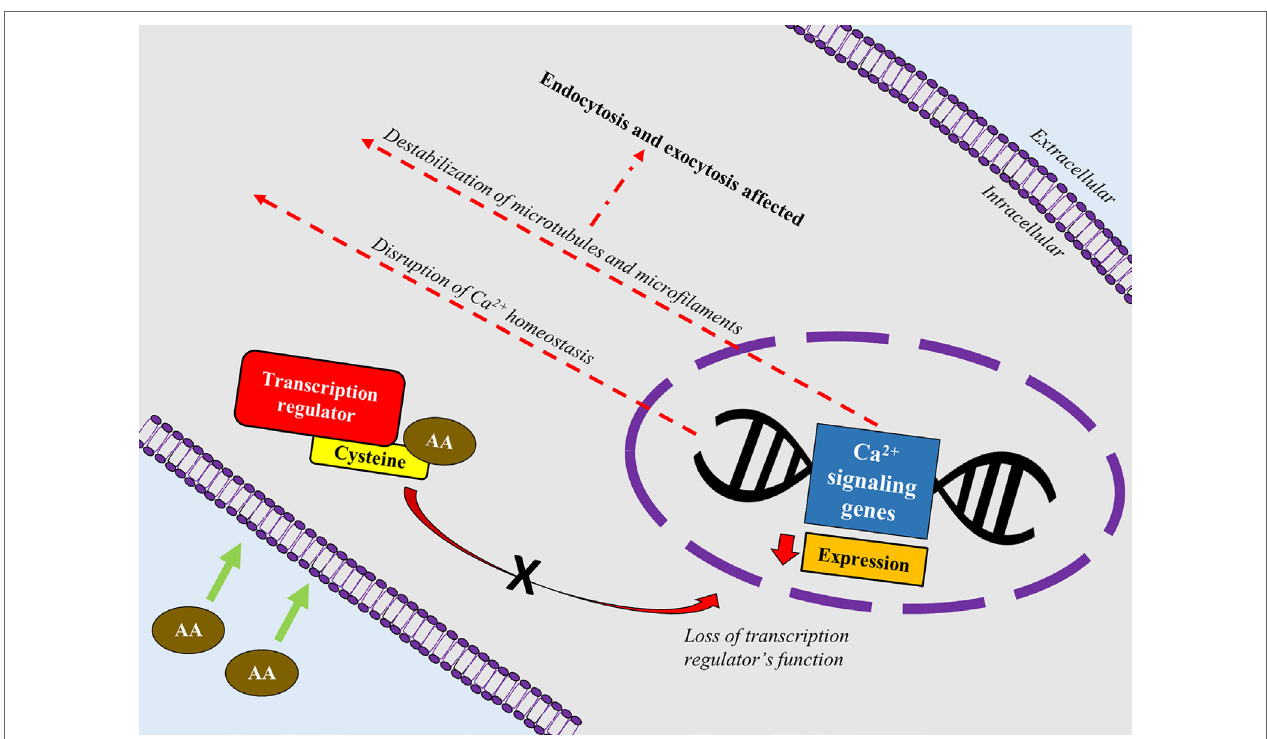
FiGURe 2 | A schematic depiction correlating calcium signaling and cytoskeletal filaments to genotoxic effects of acrylamide (AA) in rats’ testes. AA binds toward redox-sensitive Cys residues on key regulatory proteins such as transcription factors, which disrupts the protein’s function. Loss of the transcription regulator’s function causes reduced expression of calcium signaling genes and disruption of calcium homeostasis. Reduced expression of calcium signaling genes also destabilizes microtubules and microfilaments which carry out endo- and excytotic